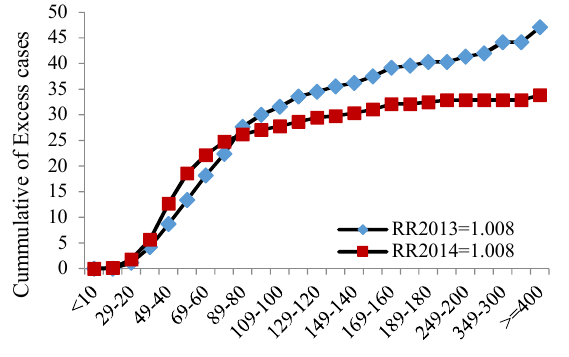
Fig. 9. Estimated total cumulative number of hospital admissions related to cardiovascular patients less than 10 microns in diameter particle model in Ilam using Air Q in 2013 and